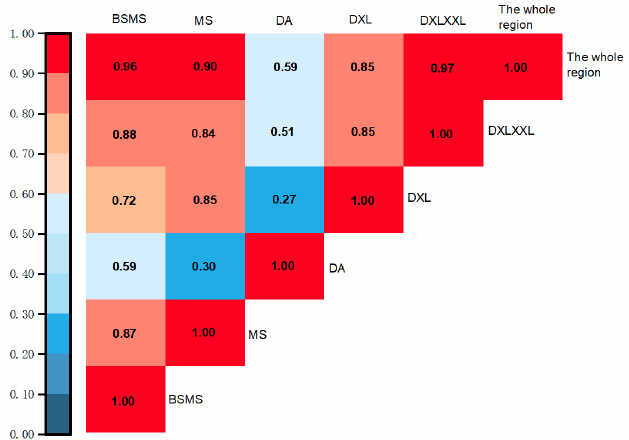
Figure 4. Correlation analysis of NDVI mean values in different geomorphological zones.